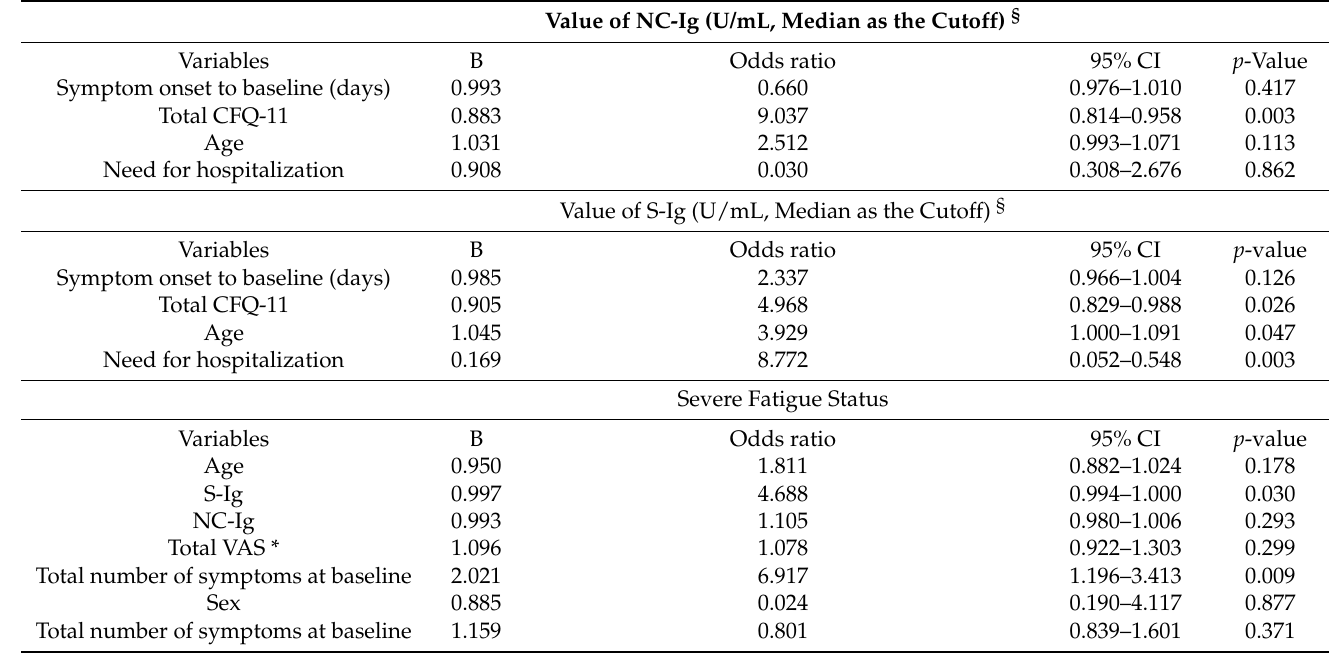
Table 4. Results of the binary logistic regression analysis examining associations between anti-SARS-CoV-2 antibody levels, severe fatigue status and demographic/clinical